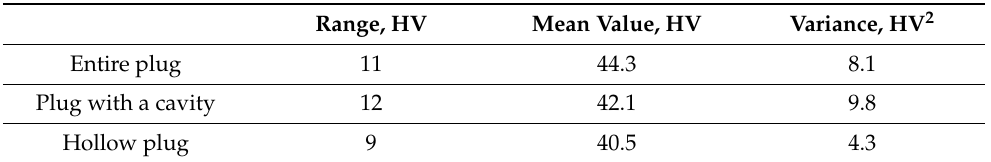
Table 1. The hardness distribution indexes in the cross-section of the hollow shells at the stationary stage of